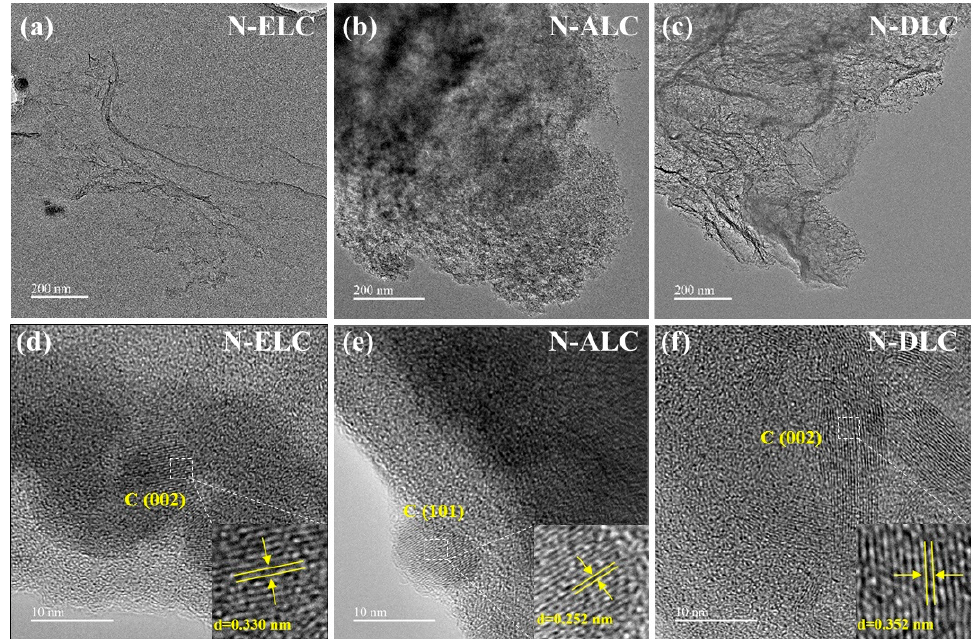
Figure 4. TEM diagrams of different kinds of lignin carbon materials: ( a , d ) N − ELC; ( b , e ) N − ALC; ( c , f ) N − DLC.